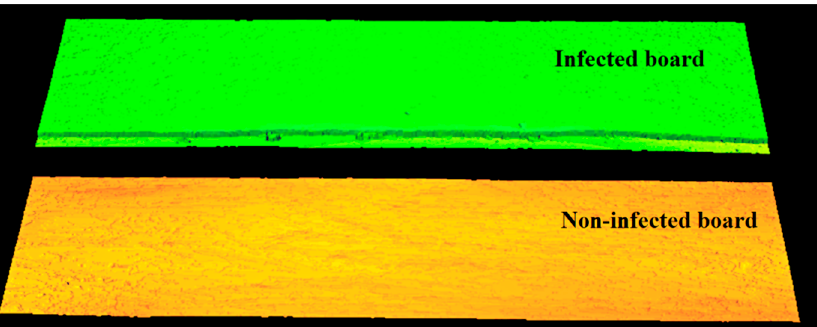
Figure 6. Three ‐ dimensional image of the surface of both boards recorded at 20 mW laser power. Figure 6. Three-dimensional image of the surface of both boards recorded at 20 mW laser power. No No occlusion on the infected area can be seen due to excessive illuminator power. occlusion on the infected area can be seen due to excessive illuminator power.